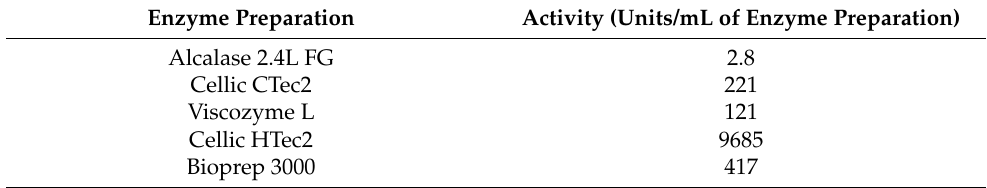
Table 1. Activities (U/mL of enzyme preparation) in the commercial enzyme preparations. Enzyme